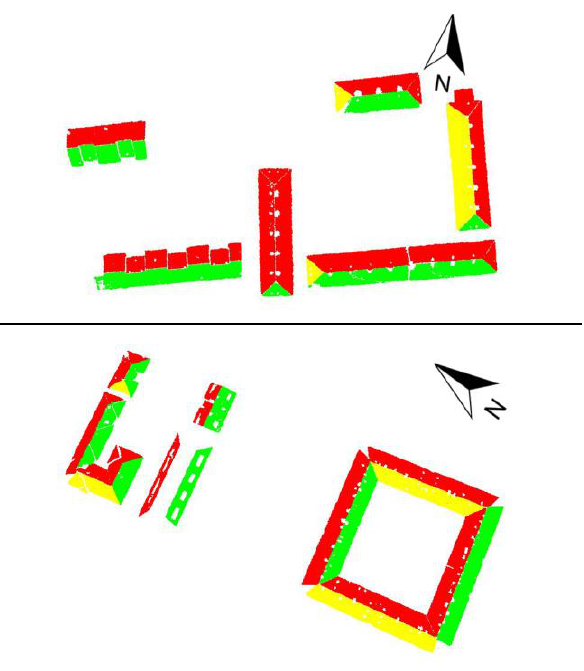
Figure 11. Details of the previous point cloud segmented and classified by its suitability to install solar panels. (Green) Surfaces suitable to install solar panels without supports. (Yellow) Surfaces suitable to install solar panels using a support to modify the solar incidence angle. (Red) Surfaces not suitable to install solar